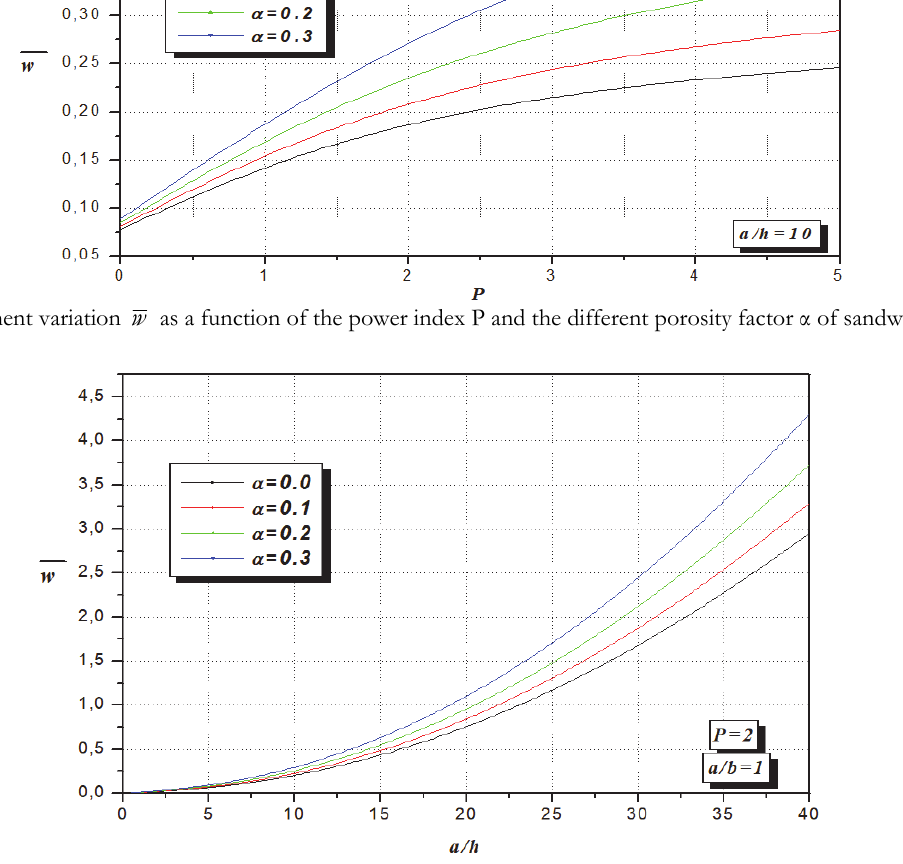
Figure 5: Dimensionless displacement variation as a function of the thickness ratio a/h for the different values of porosity coefficient for plate sandwich